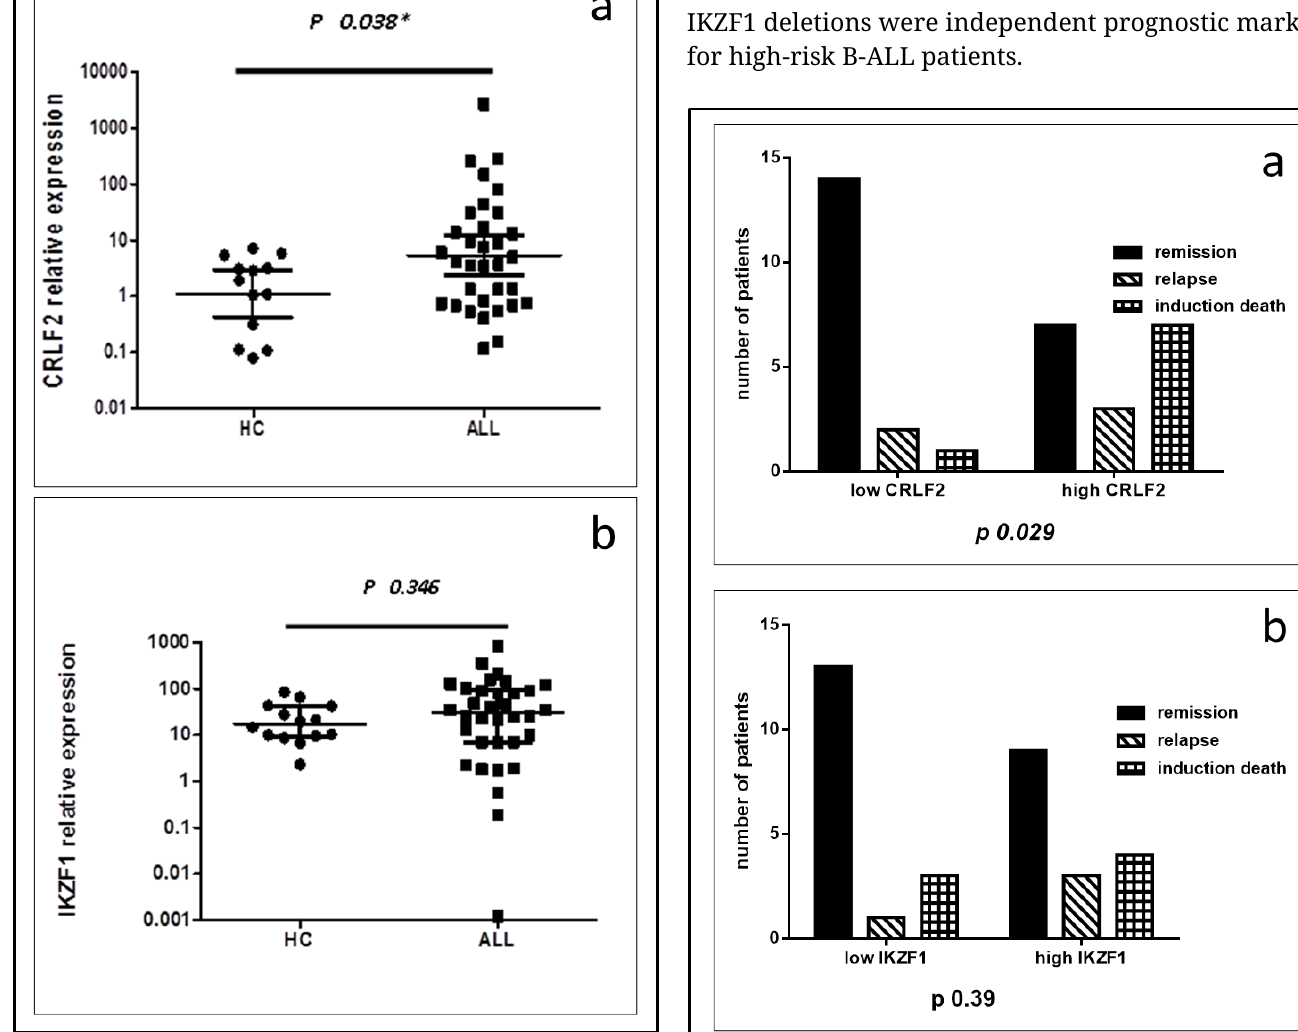
Figure 2: Correlation between CRLF2 (a) and IKZF1 (b) expression and treatment outcome in acute lymphoblastic leukemia